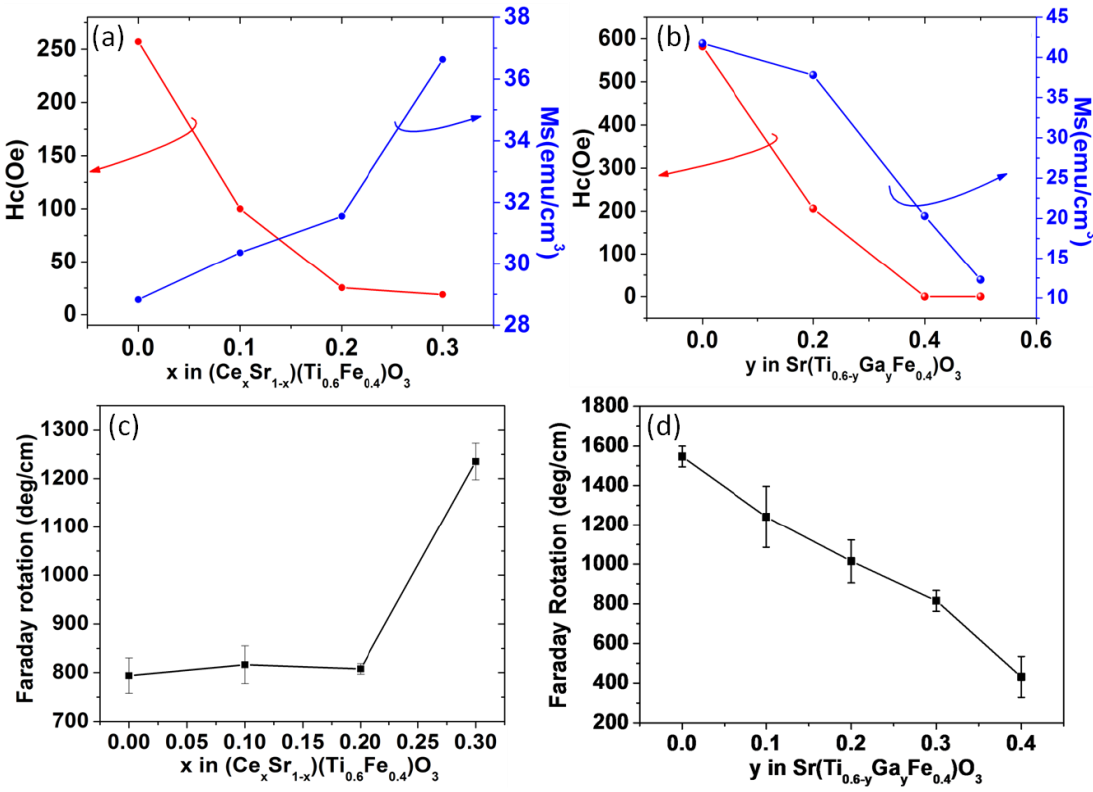
Figure 4. Room temperature saturation magnetization and coercivity of ( a ) Ce substituted STF and ( b ) Ga substituted STF films on LSAT substrates. Also shown are the Faraday rotations as a function of dopant concentration for ( c ) Ce substituted STF and ( d ) Ga substituted STF films [99,100] on LSAT. (Reprinted with permission from [99,100]. Copyright 2011 AIP Publishing LLC).